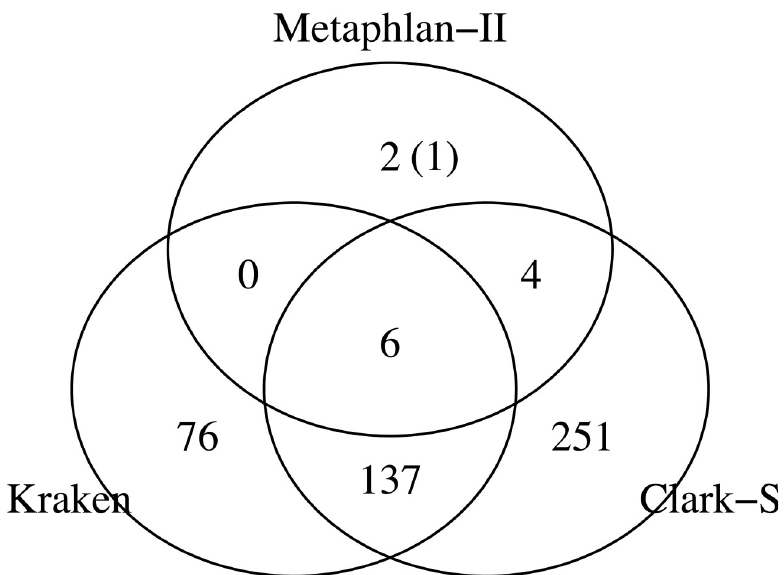
Fig 2. Predicted taxonomical composition of mock community. Abundances of reported species as from the three classification methods. Metaphlan-II classifications were all correct, except one falsely classified. Most of the classifications by Kraken and Clark-S were false positives. The value given in brackets represents an additional species identified.